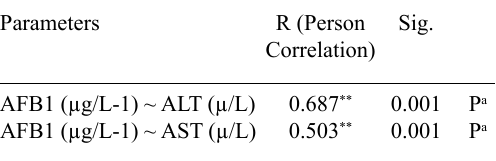
table 3. Correlation between AFB1 and age Parameters